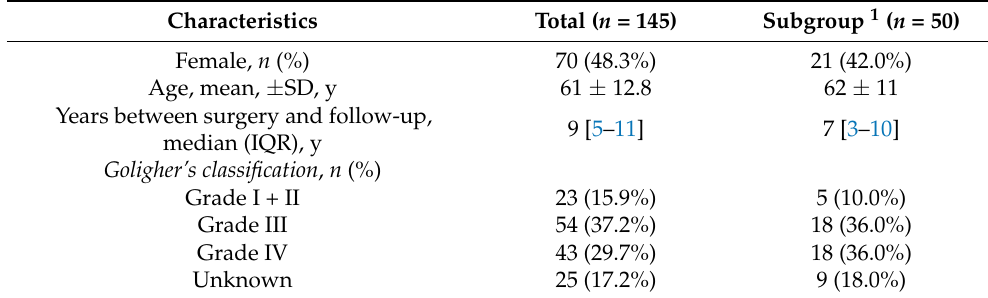
Table 1. Patient characteristics ( n = number, y = years).